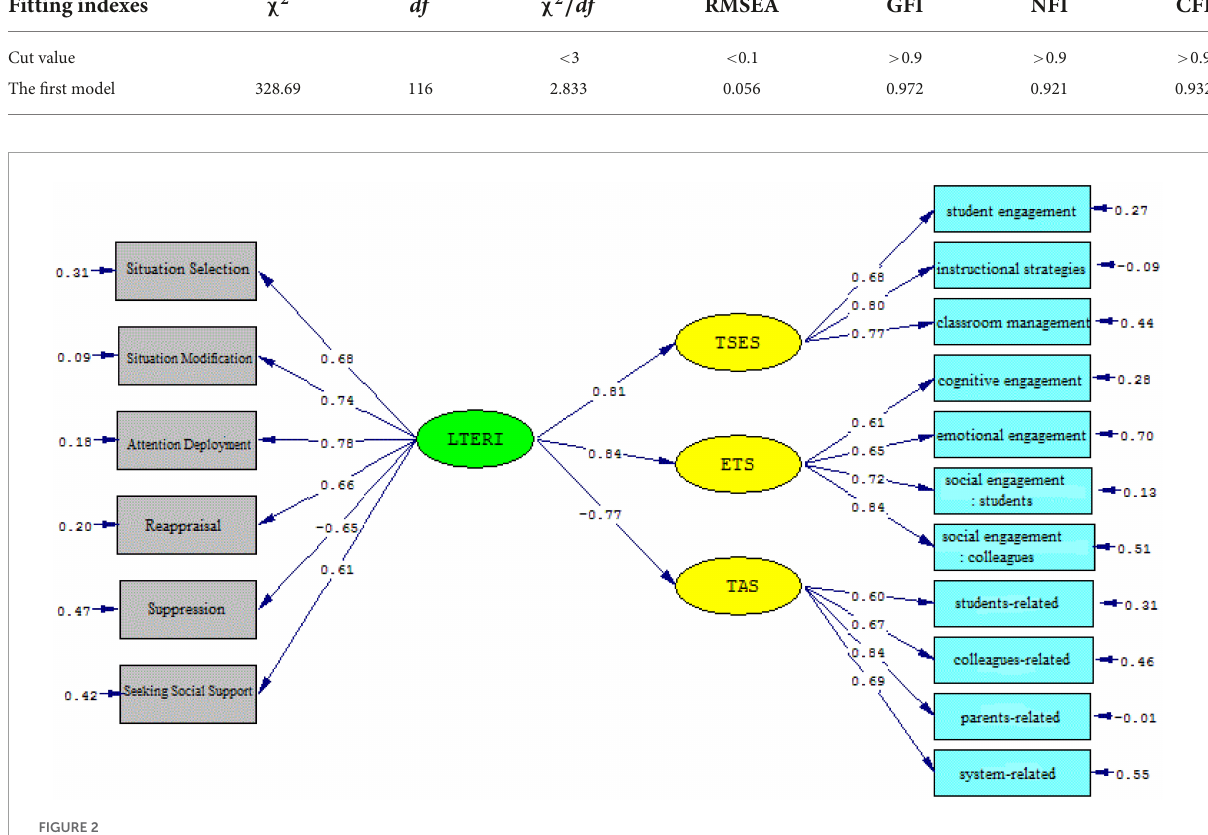
FIGURE2 The schematic representation of path coefficient values (Model 1).